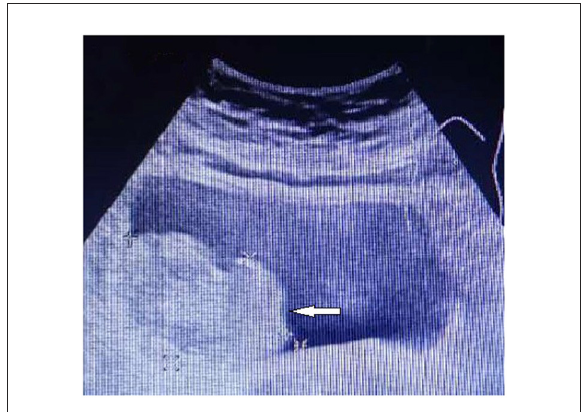
FIGURE1 Color Doppler showing the lesion in the right wall of the urinary bladder.